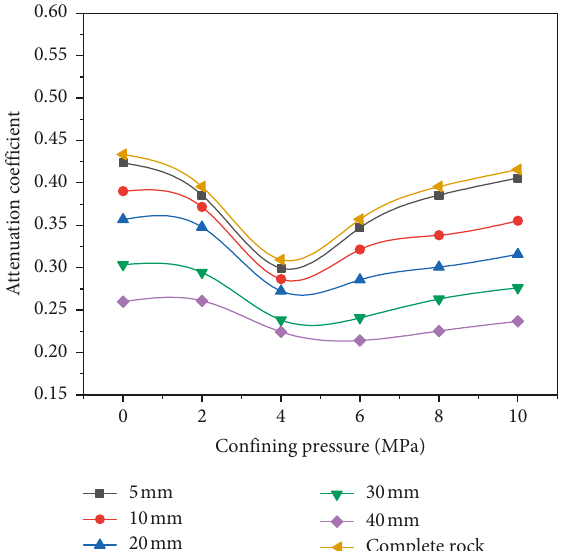
Figure 12: Variation of the attenuation coefficient with confining pressures.